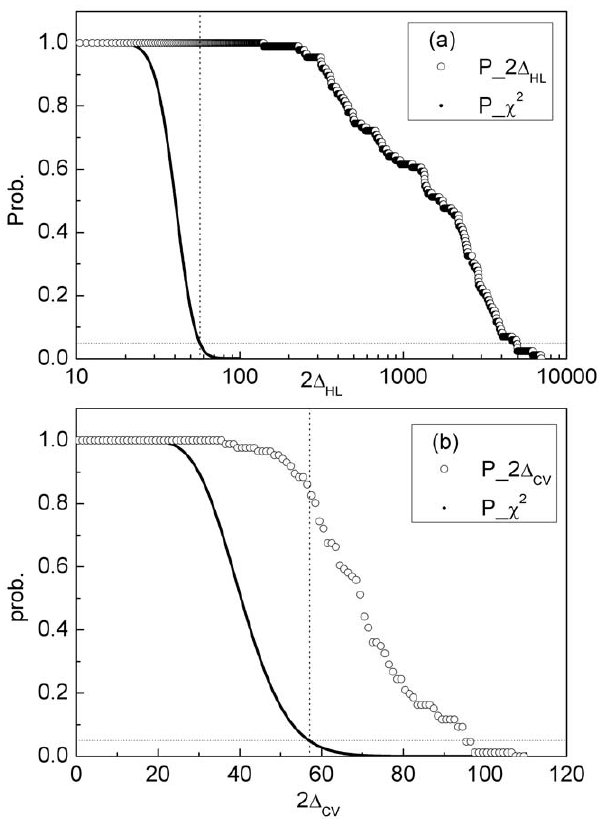
Figure 1. Cumulative probability distribution of 2 D . Distributions are shown for our data (symbols) and for the x 2 distribution expected in the null hypothesis (solid line). (a) For the HL comparison, the distribution of 2 D is very much different than expected under the null hypothesis. 100% of species have a 2 D value that is significant at the 5% level (shown by the vertical dashed line). (b) For the CV comparison, the distribution also differs noticeably from the null hypothesis, with 80% of species having a 2 D value significant at the 5% level.